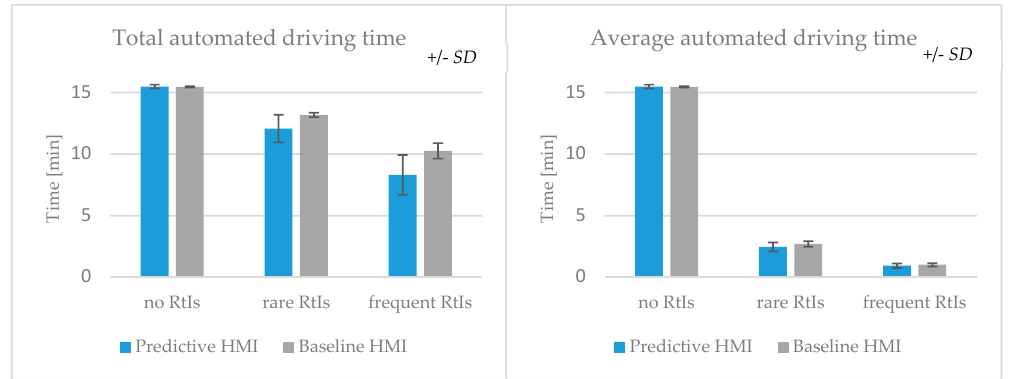
Figure 8. Total automated driving time per drive and HMI condition, average automated driving time per drive and HMI condition; error bars represent standard deviation.